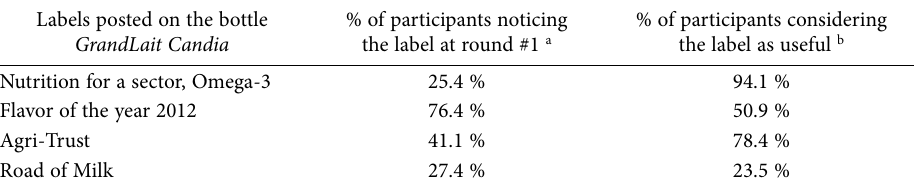
Table 1. Participants’ opinion about the labels from the exit questionnaire. Labels posted on the bottle % of participants noticing % of participants considering GrandLait Candia the label at round #1 a the label as useful b Nutrition for a sector, Omega-3 25.4 % 94.1 % Flavor of the year 2012 76.4 % 50.9 % Agri-Trust 41.1 % 78.4 % Road of Milk 27.4 % 23.5